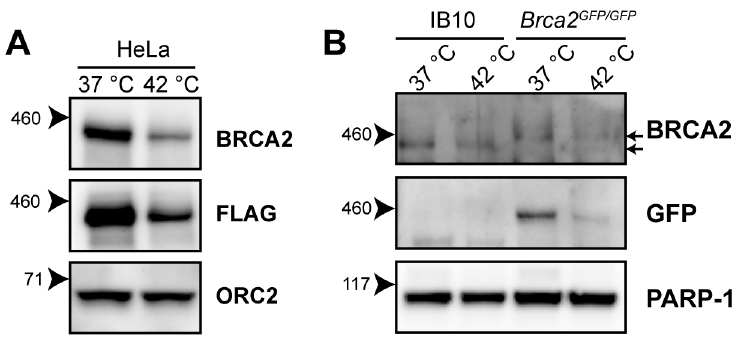
Figure 1. Heat-mediated degradation of BRCA2 and modulation of homologous recombination (HR). ( A ) Immunoblot of HeLa cells stably expressing expressing BRCA2, tagged with the FLAG epitope (DYKDDDDK), treated with or without 60 min of hyperthermia. ( B ) Immunoblot of wild-type IB10 and BRCA2 GFP/GFP mouse embryonic stem (mES) cells. The upper and lower arrow next to the upper BRCA2 panel indicate the positions of BRCA2-GFP and untagged BRCA2, respectively.